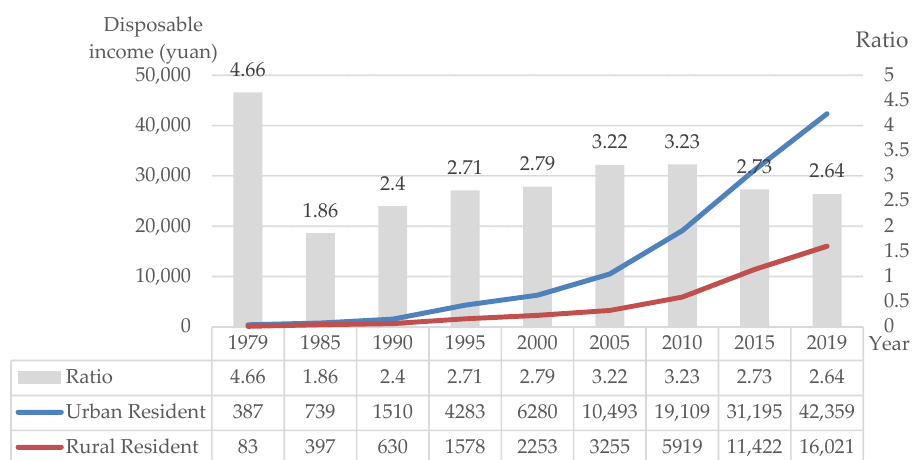
Figure 5. The annual disposable income of urban and rural residents from 1979 to 2019 in China (Data source: National Bureau of Statistics).